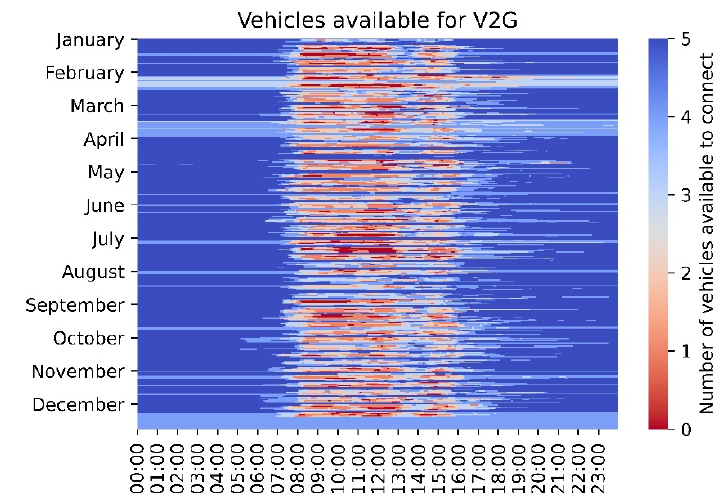
Figure 6. Number of vehicles parked close to a proposed V2G charger for more than 30 min over the one-year historical dataset. Dark blue means all vehicles five vehicles were parked next to a charger, and red means that none of the vehicles was available to connect to a V2G charger.